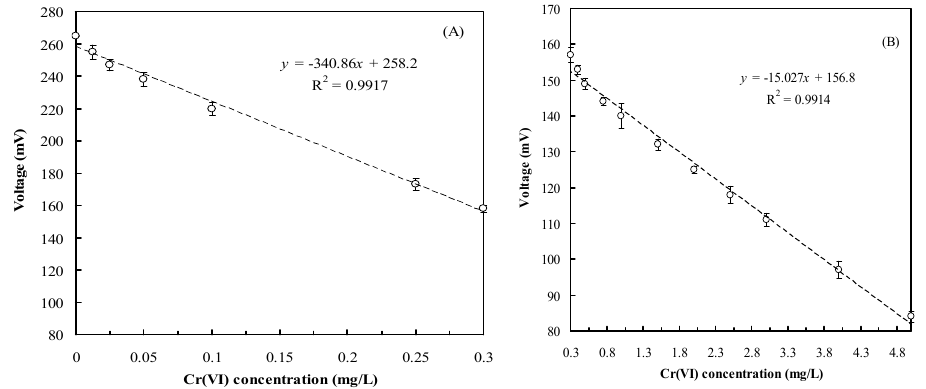
Figure 4. Relationship between Cr(VI) concentration and voltage output of the MFC biosensor: ( A ) Cr(VI) concentration: 0.0125 to 0.3 mg/L; ( B ) Cr(VI) concentration: 0.3 to 5 mg/L (operational temperature: 35 °C, resistance of external circuit: 270 Ω , anolyte: 1/1000 LB supplemented with different Cr(VI) concentration, catholyte: 50 mM phosphate and 25 mM NaCl, response time: 45 min).